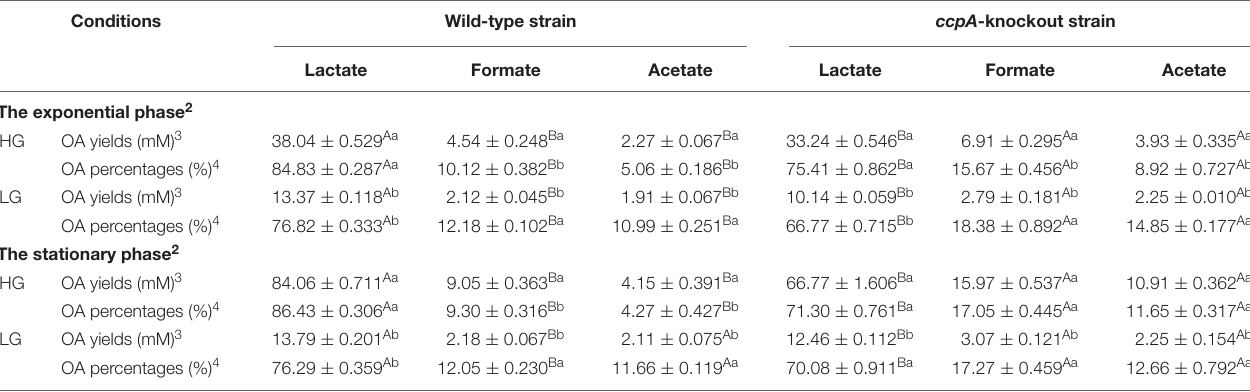
TABLE 1 | The organic acid production characteristics of S. bovis S1 wild-type strain and ccpA -knockout strain at the exponential and stationary phases in glucose-excess or -limited conditions. 1